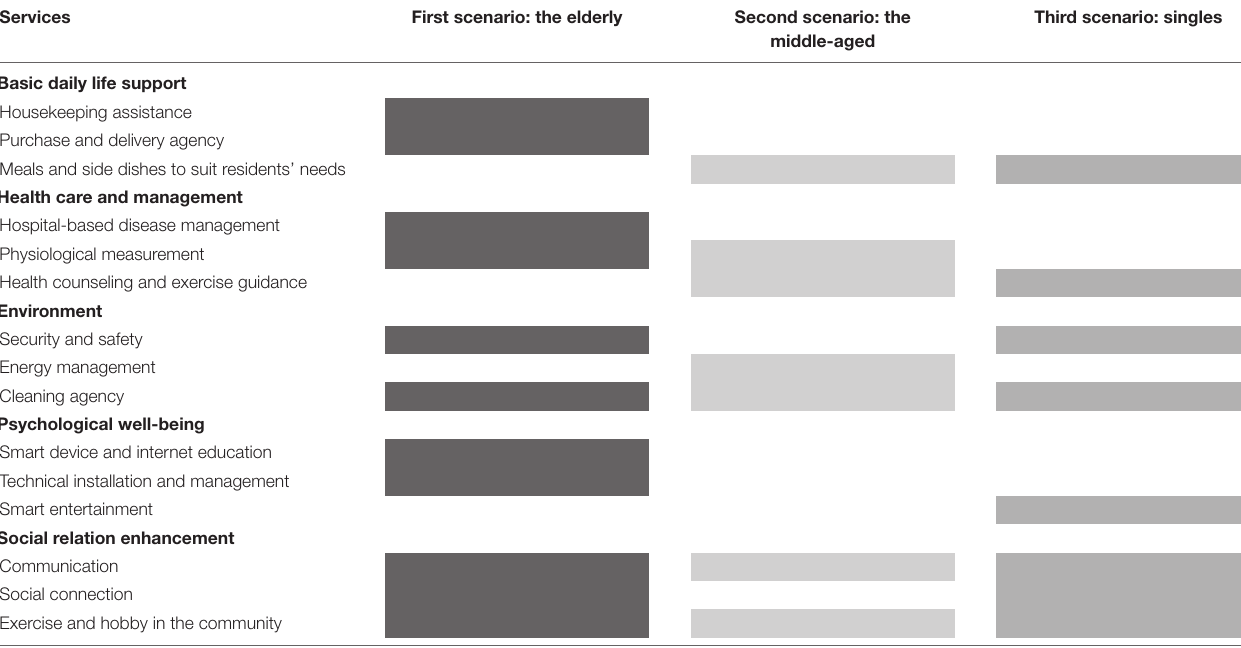
TABLE 4 | Customized smart home services.